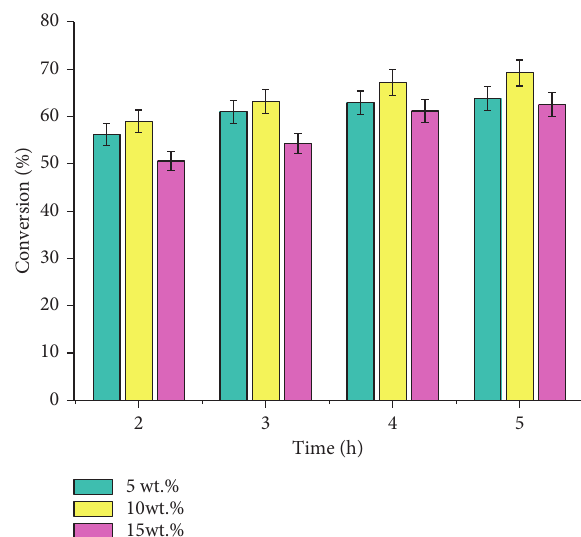
Figure 7: The effect of catalyst amount on the oleic acid conversion over the HPW@CoCeO catalyst.